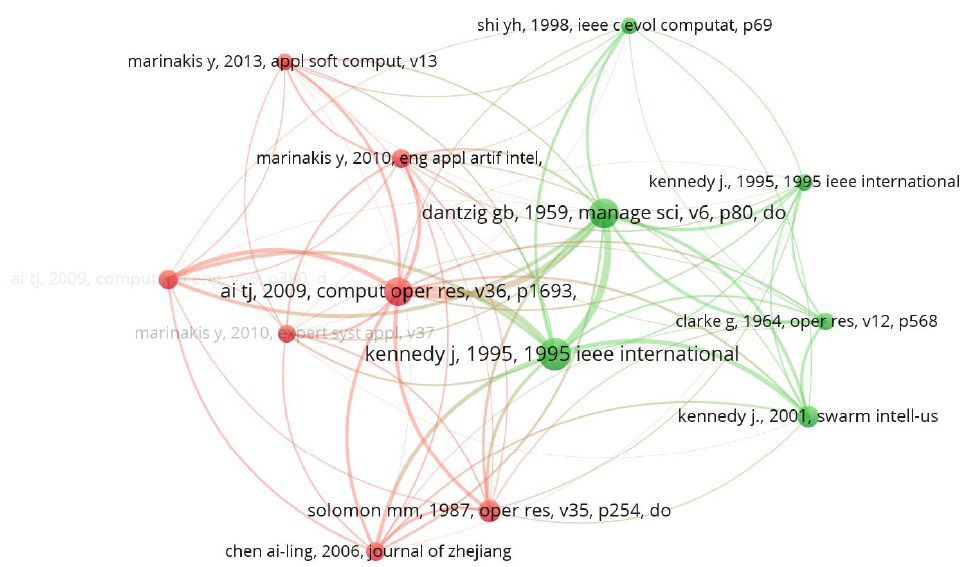
Figure 13. Co-citation reference network for the Web of Science database search, 10 minimum citations [1,3,15,22,30,31,31,43,47,58,59].